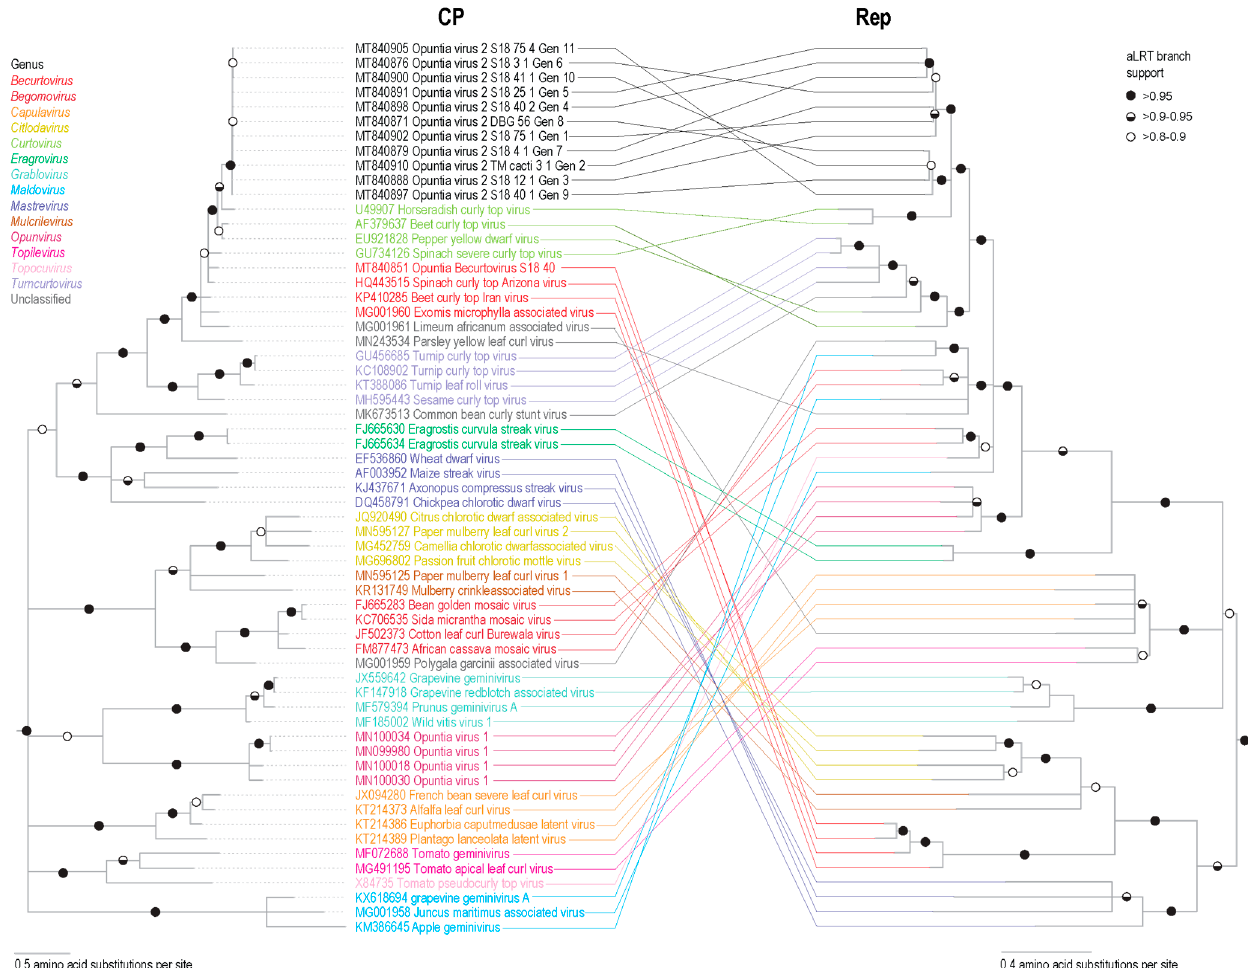
Figure 2. Maximum-likelihood phylogenetic tree of the Rep and CP amino acid sequences of the eleven representative genotypes of OpV2 and Opuntia becurtovirus, and representative sequences from various genera in the family Geminiviridae . Branches with <0.8 aLRT support have been collapsed and the trees are rooted with sequences of genomoviruses [62] .